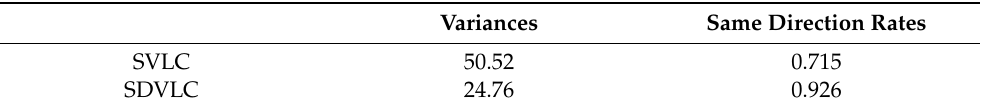
Table 3. Comparison of the variance and same direction rate between SVLC and SDVLC, obtained by the